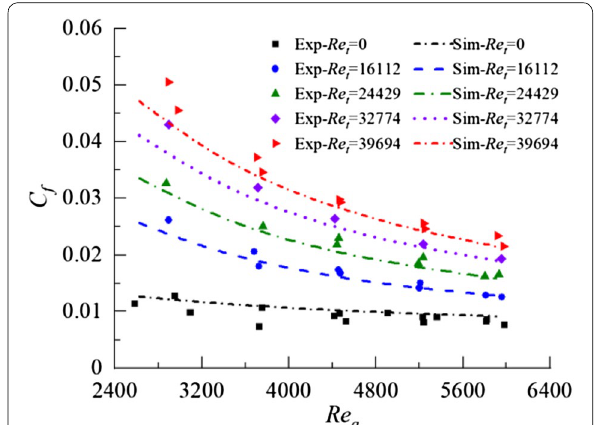
Figure 6 Validation of the simulated C f against Re a and Re t with η 0.968 =